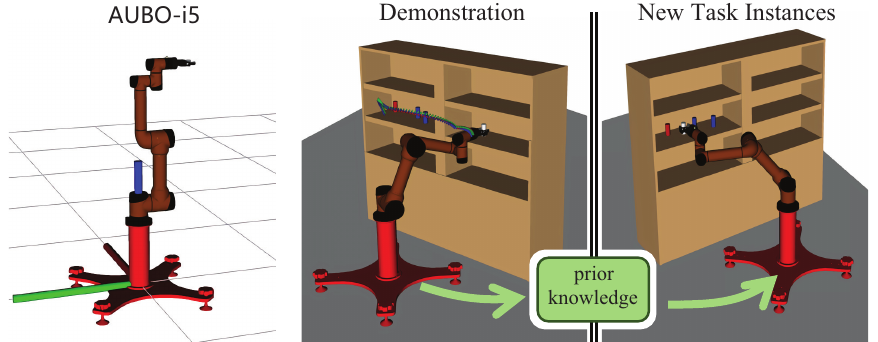
Figure 1. Our planner can generalize and leverage the high-quality paths solved by the expert planner to solve new task instances. The expert planner plans the paths by searching the manipulation tasks and collecting and using these paths as priori knowledge to solve new motion planning problems quickly and consistently to grab all the cylinders on the left and place them on the right side of the shelf, thus avoiding